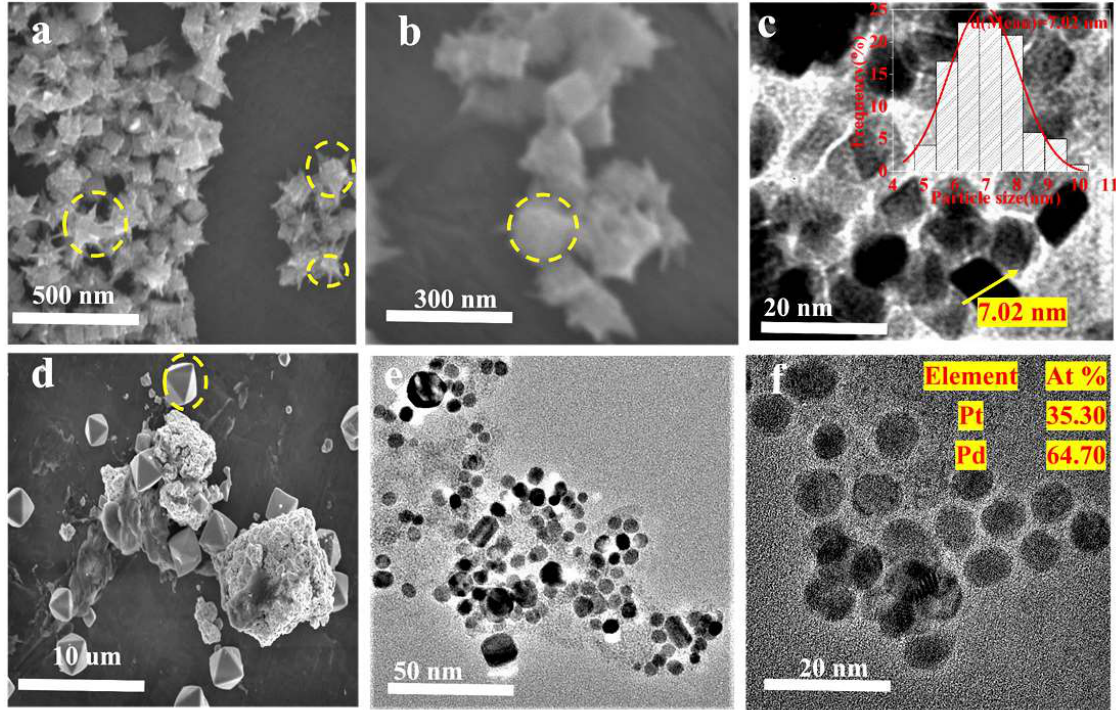
Figure 3. ( a – f ) SEM and TEM images of Pt-Ni nanoparticle catalyst, Pt-Pd nanospheres, Pd-Ni nanoparticle catalyst, and Pt-Pd-Ni alloy catalyst by the one-step solvothermal method: ( a , b ) Pt-Pd-Ni alloy catalyst synthesized by the one-step solvothermal method; ( c ) Pt-Ni bimetallic alloy catalyst; ( d ) bimetallic alloy catalyst synthesized by Pd seed and Ni; ( e , f ) bimetallic alloy catalyst synthesized by Pd seed and Pt.